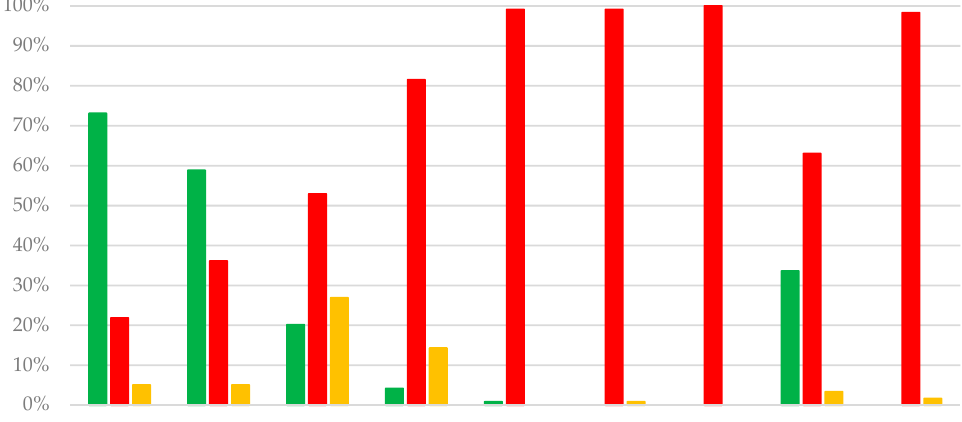
Figure 3. Percentages of “correctly recognized”, “unrecognized” and “wrongly recognized” signs per scenario.